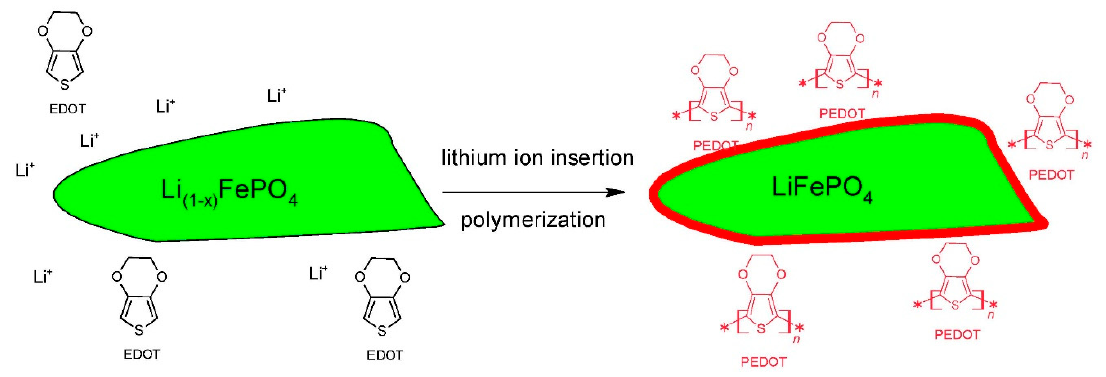
Figure 2. Scheme of coating of LiFePO 4 with PEDOT:PSS. *: chain continuation.